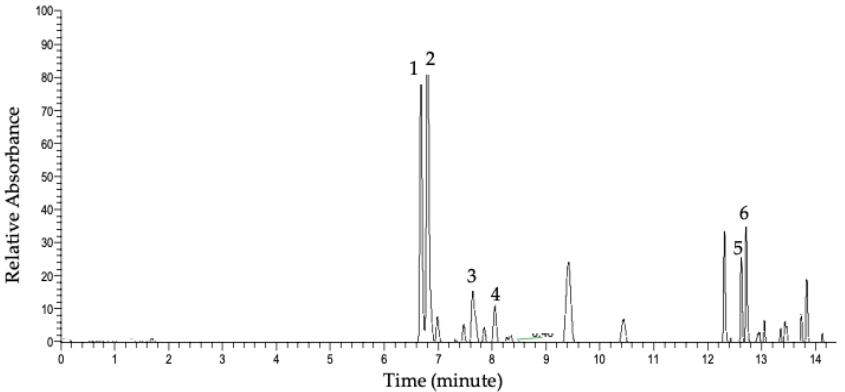
Figure 2. Representation acquired by ultra-high-performance liquid chromatography (UHPLC)- Figure2. Representationacquiredbyultra-high-performanceliquidchromatography(UHPLC)-photodiode photodiode array (PDA) at 350 nm of whole ramps ’ methanolic extract. Peak numbers refer to table array (PDA) at 350 nm of whole ramps’ methanolic extract. Peak numbers refer to Table 1, as determined by UHPLC-PDA-MS and MS / MS. Table 1. UHPLC-PDA-MS and MS/MS data and putative identification of flavonol glycosides Table 1. UHPLC-PDA-MS and MS / MS data and putative identification of flavonol glycosides detected detected in ramps. in